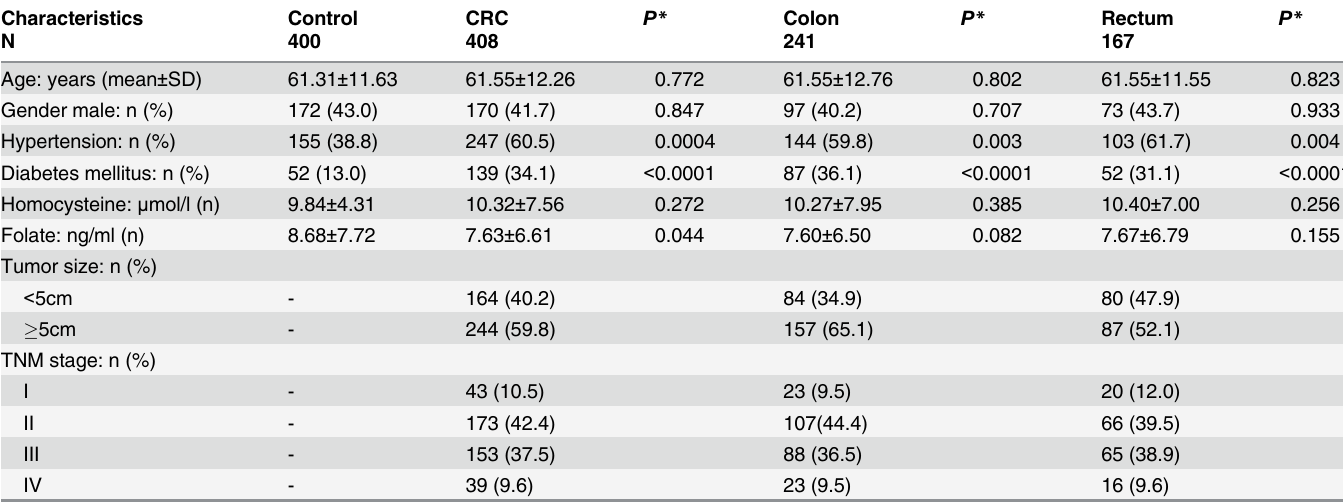
Table 1. Baseline characteristics of colorectal cancer patients and control